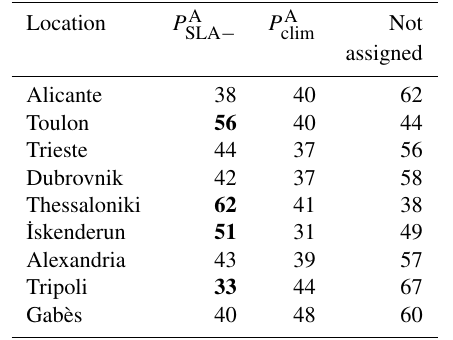
Table 4. The same as Table 2 except that it refers to negative sea level anomalies; the presence of anticyclones and the columns with information on the genesis of the anticyclones are not reported. The columns, labelled “ P A ” and “ P A ”, report the probability (%) SLA − clim of finding an anticyclone within a 10 ◦ search radius from the refer- ence point (denoted with a yellow square in Fig. 8) at the time of the event, the corresponding climatological mean value and of failing in detecting the presence of an anticyclone, in this order. Bold values denote differences between P A and P A that are statistically SLA − clim significant at the 95%